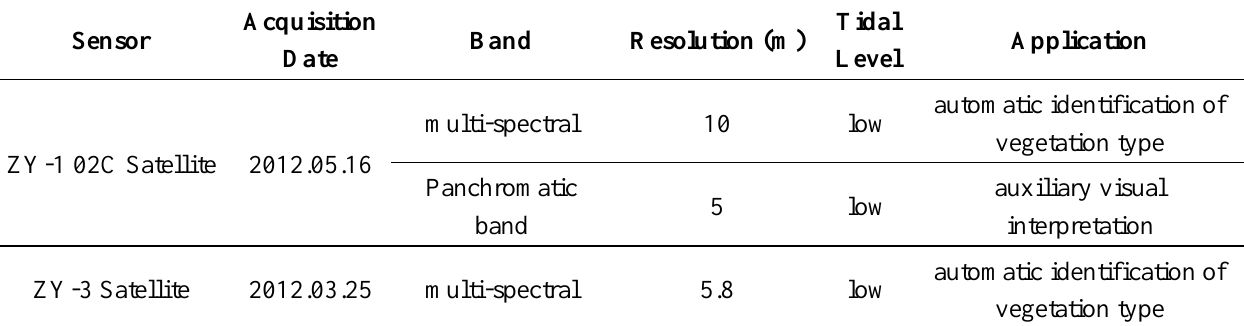
Table 1. The characteristics of selected remote sensing